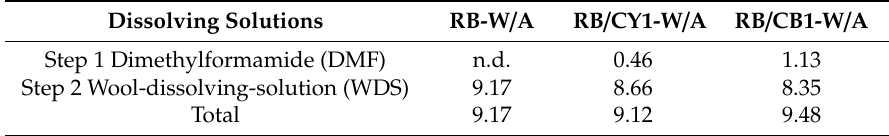
Table 3. RB loadings ( µ mol / g fabric) of 3% o.w.f RB and 1% o.w.f CY / CB treated fabrics (RB / CY1-W / A and RB / CB1-W / A) in comparison with RB-W /